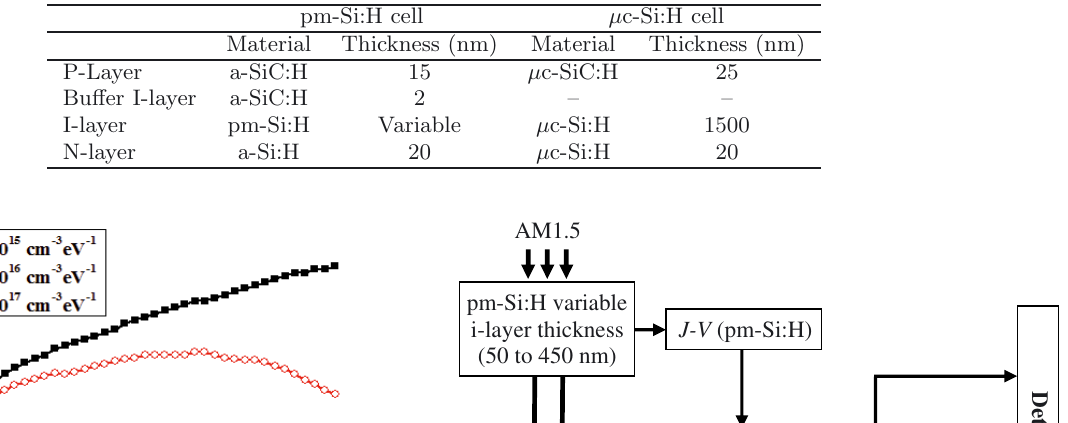
Table 2. Layer thicknesses for pm-Si:H and μ c-Si:H cells as used in simulation.